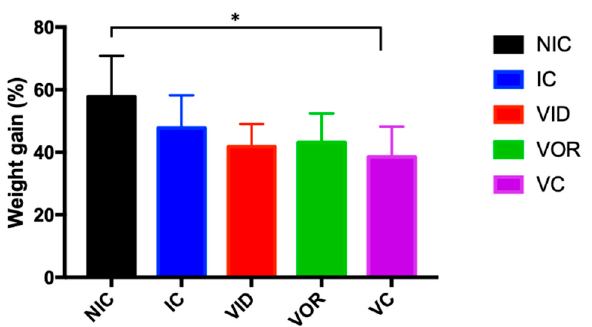
Figure 1. Weight gain during experimental period. Bars represent the mean and the error bars the standard error of the mean (SEM). * Significant differences were detected by Dunnet’s post hoc between the non-infected control group (NIC) and the control vaccine (VC) group ( p = 0.024). At necropsy, lesions compatible with PTB infection consisting of mild and moderate ileum and distal jejunum thickness, intestinal and mesentery lymphangiectasia and presence of white spots corresponding to caseous necrosis foci in SR and VA were observed (Figure S1). These lesions were present in 60% of animals belonging to the IC group, 40% of the VID group and 80% of VOR and VC groups (Table 2). MAP was detected by PCR in 80% of animals of the IC, VOR, and VC groups and in 40% of animals belonging to the VID group (Table